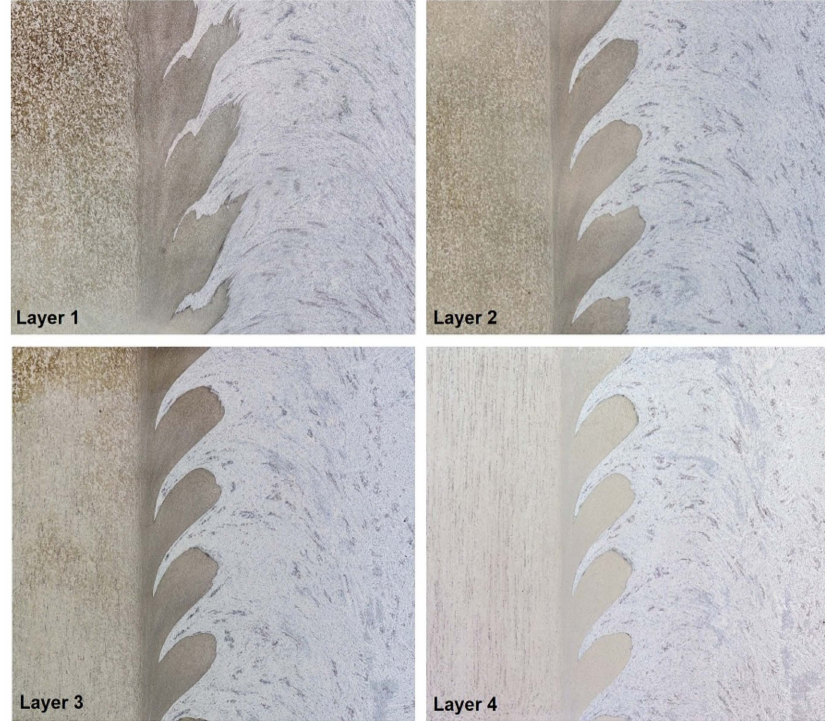
Figure 5. Visualization of four selected layers where the evolution of the microstructures can be